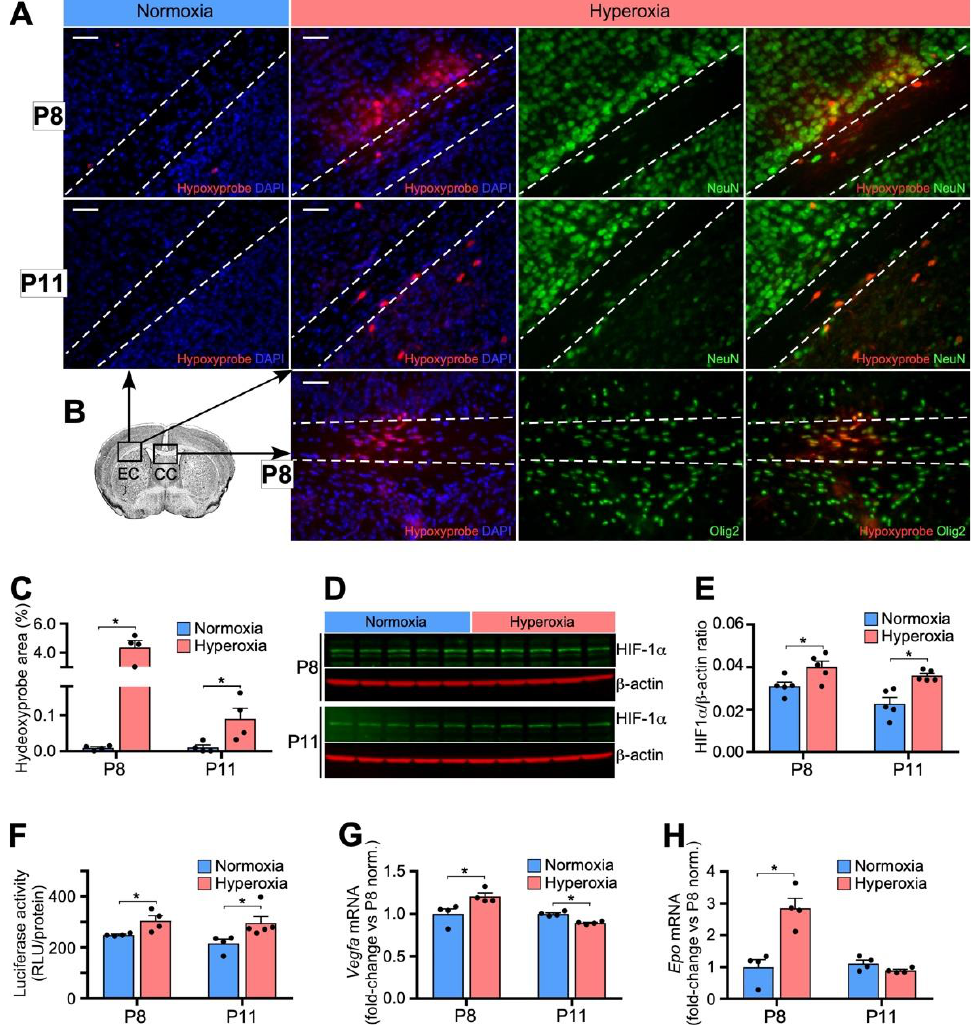
Figure 4. Hyperoxia induces relative hypoxia. ( A ) Hyperoxia from P4 – P8 increases Hypoxyprobe staining compared to normoxia at P8, 6 h after removal from hyperoxia, and at P11, 3 days after removal from hyperoxia. Double-staining for either neurons (green, NeuN) upper 2 panels, oligodendrocytes (green, Olig2) and red (Hypoxyprobe) reveals both hypoxic neurons and oligodendrocytes after phase 1 hyperoxia followed by phase 2 relative hypoxia. Dashed lines mark the histological margins of the EC or CC as shown in the following schematic. Scale bar = 50 µ m. ( B ) Schema demonstrating area of sections from either the Corpus Callosum (CC) or the External Capsule